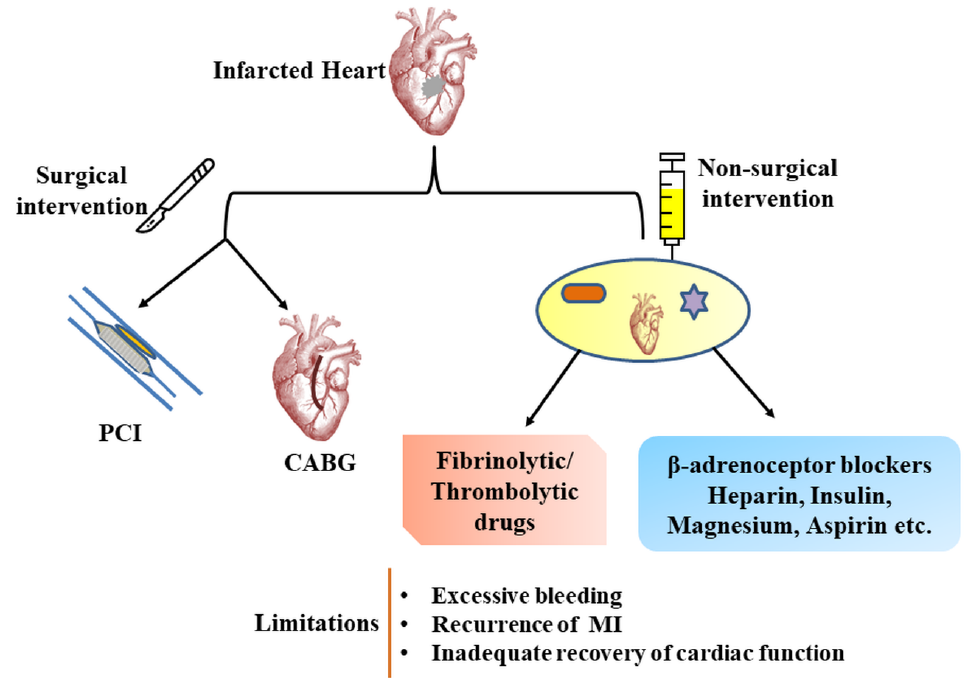
Figure 2. Conventional therapeutic surgical and non-surgical measures for addressing MI and their limitations. The selected approach relies on progression of MI and patient’s condition. CABG: Coronary artery bypass graft, PCI: Percutaneous coronary intervention.